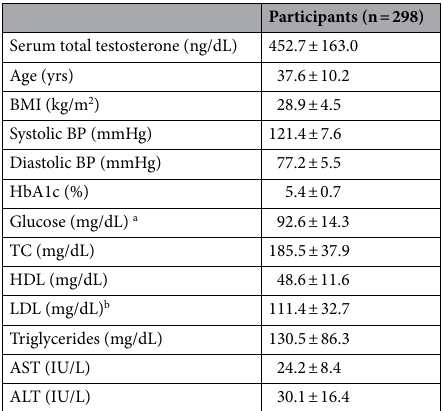
Table 1. Characteristics of the study population. Variables are expressed as mean ± standard deviation; BMI: body mass index; BP: blood pressure; HbA1c: glycated hemoglobin; Different sample sizes for the variables due to missing data: a Sample size is n = 293; b Sample size is n =